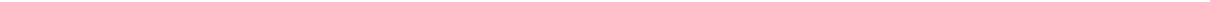
Fig. 2 Endogenous Wnt8 shows not only a gradient but also HS-dependent punctate distributions. a The gradient of the endogenous Wnt8 protein from the lateral to mid-dorsal marginal zones at the mid-gastrula stage (st. 11.5). The observed region is indicated by the cyan box (reported localization of wnt8 mRNA in magenta). Embryos were fl at-mounted under a coverslip and the image was acquired using automatic tiling with the maximum intensity projection of z -stacks (junctions of tiling appeared darker, arrowheads). b Quanti fi cation of the gradient of Wnt8 staining ( a ). The junctions of tiling are indicated by dotted lines, showing the drop in intensity. c A high-resolution image of endogenous Wnt8 staining in the VMZ. wnt8 is expressed in the underlying mesoderm, but not in the super fi cial layer in Xenopus embryos. An optical section at the subapical region of cells (basal to the tight junction) of the super fi cial layer is shown (see also Supplementary Fig. 2b, d). d Exogenous mV-Wnt8 expression and heparitinase treatment. Experimental procedures are illustrated on the left. Embryos were observed at stage 10.5. The source cells are indicated with “ * ” . e Immunostaining of HS chains with NAH46 (for N- acetyl HS) or HepSS-1 (for N- sulfo HS). Notably HepSS-1 staining shows puncta inside cells (orange arrowheads). f – k The colocalization of endogenous Wnt8 and a subpopulation of HS. Gastrula embryos (st. 10.5) were co-immunostained for Wnt8 and NAH46 epitope ( N- acetyl HS) or HepSS-1 epitope ( N- sulfo HS) at the VMZ ( f , i ). Signal intensities along white arrows were plotted ( g , j ), starting and ending points as indicated by yellow and cyan arrowheads, respectively ( f , i ). Scatter plots show the indicated signal intensities for every pixel along the arrow, presented with correlation coef fi cients ( r ) ( h , k ). Note N- sulfo-rich HS clusters inside cells, with Wnt8 (orange arrowheads) and without Wnt8 (white arrowheads). Staining of N- acetyl HS was absent from the Wnt8 puncta inside cells (open arrowheads in f ). Images are a representative of at least two independent experiments. Amounts of mRNA (ng/embryo): mV-wnt8 , 1.0; mRFP , 0.50. Scale bars, 100 μ m ( a ); 10 μ m ( c – f , i ). a.u., arbitrary